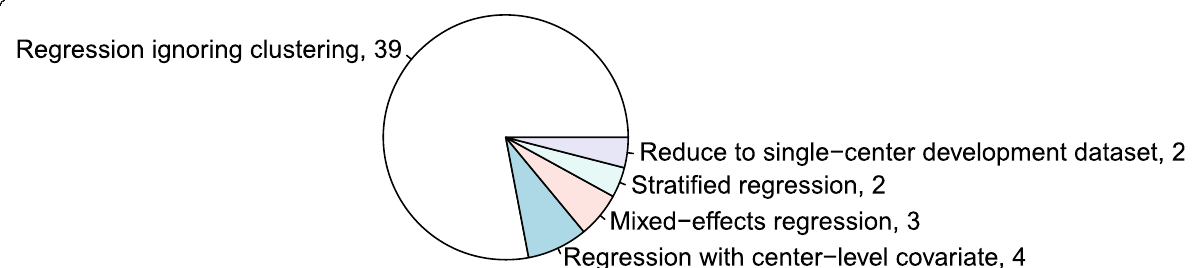
Fig. 4 Analysis techniques used for model building in 50 randomly selected multicenter